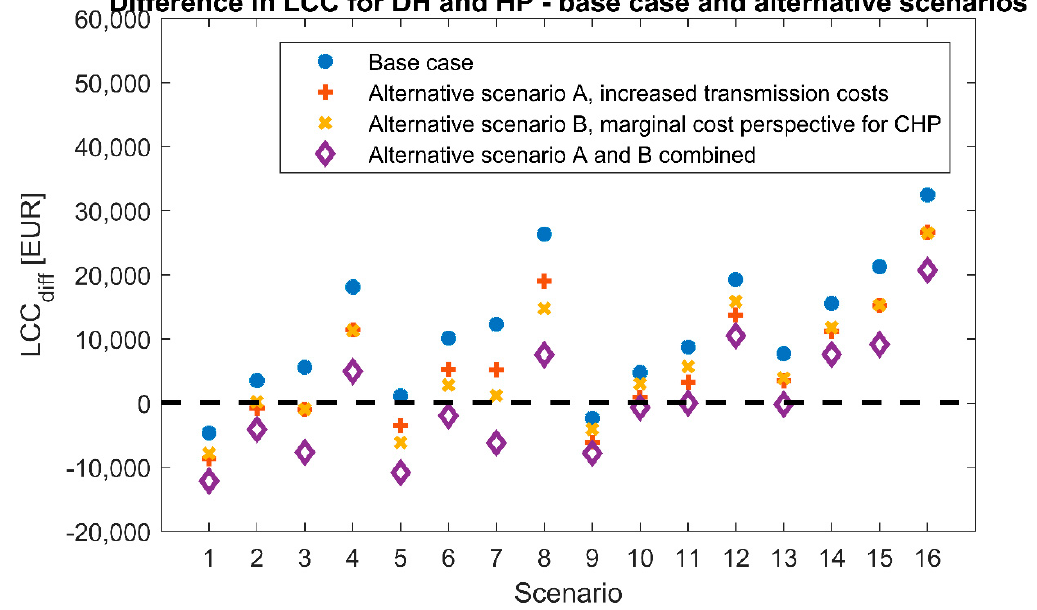
Figure 6. The LCC diff mean value for the base case and the alternative scenarios. Alternative scenario A with an increased cost for the HP case due to additional investments in the transmission grid, demand response flexibility, and energy storage. Alternative scenario B where marginal cost is considered for the CHP investment. A combination of the two alternative scenarios. The points below the dashed line are negative values, i.e., the DH case is cheaper.